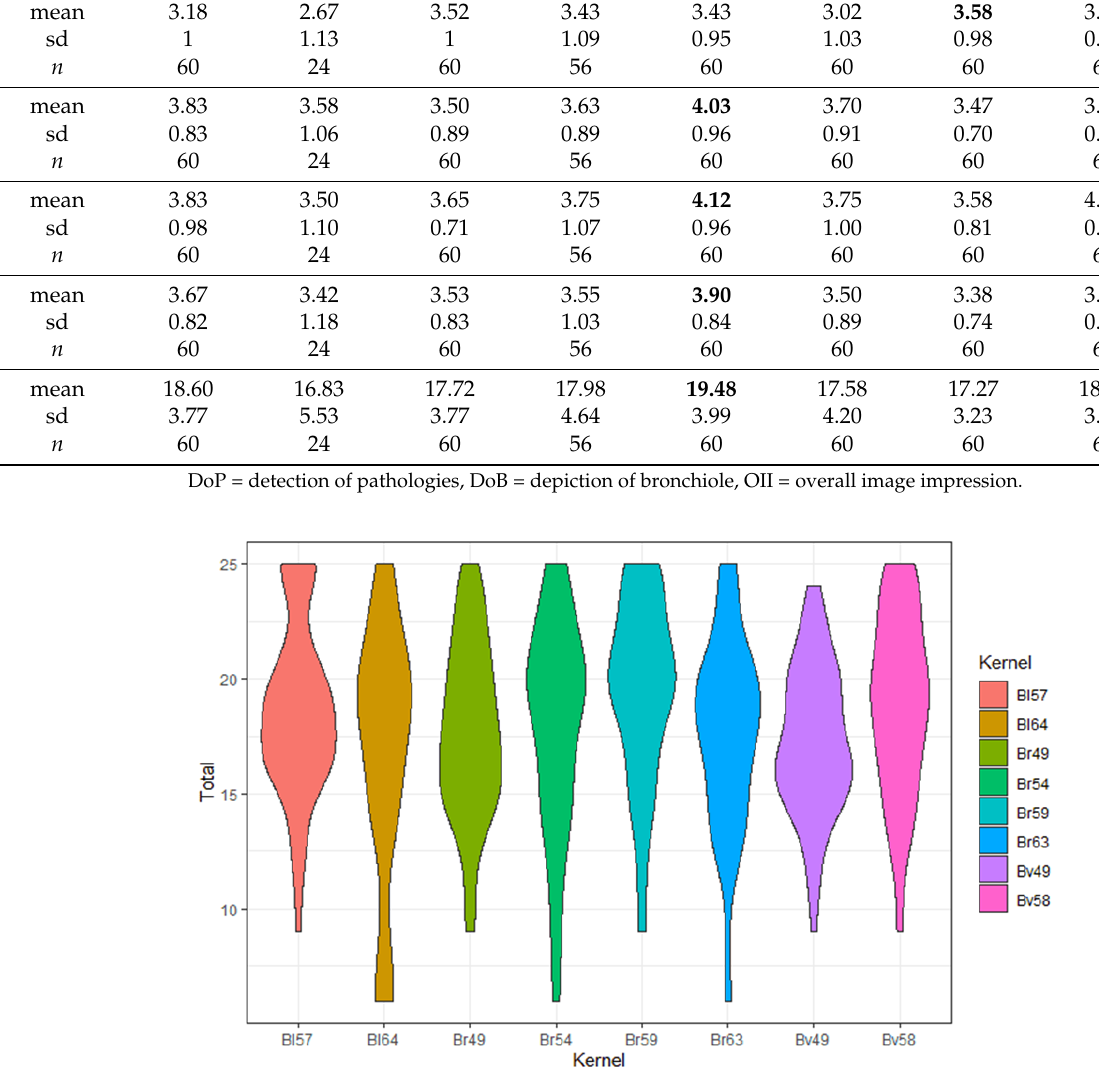
Figure 1. Violin plot: Total score, mean for all 4 raters, violin plot with the score distribution (X-axis: summed up 5-point Likert scale, Y-axis: Kernel) (violin plot represents kernel density estimation to show the distribution shape of the data. Wider sections of the violin plot represent a higher probability that kernel rating will take on the given value; the skinnier sections represent a lower probability).